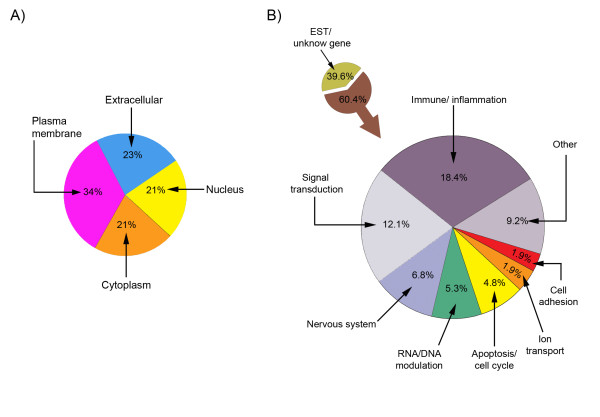
Cellular location (A) and functional groups (B) of the mRNA Affy_IDs from adult dorsal root ganglia 7 days post spared nerve injury. Unknown refers to those Affymetrix entries that are either unknown genes or expressed sequences tag (ETS) that correspond to "transcribed loci" and "similar-to-genes" mRNAs.